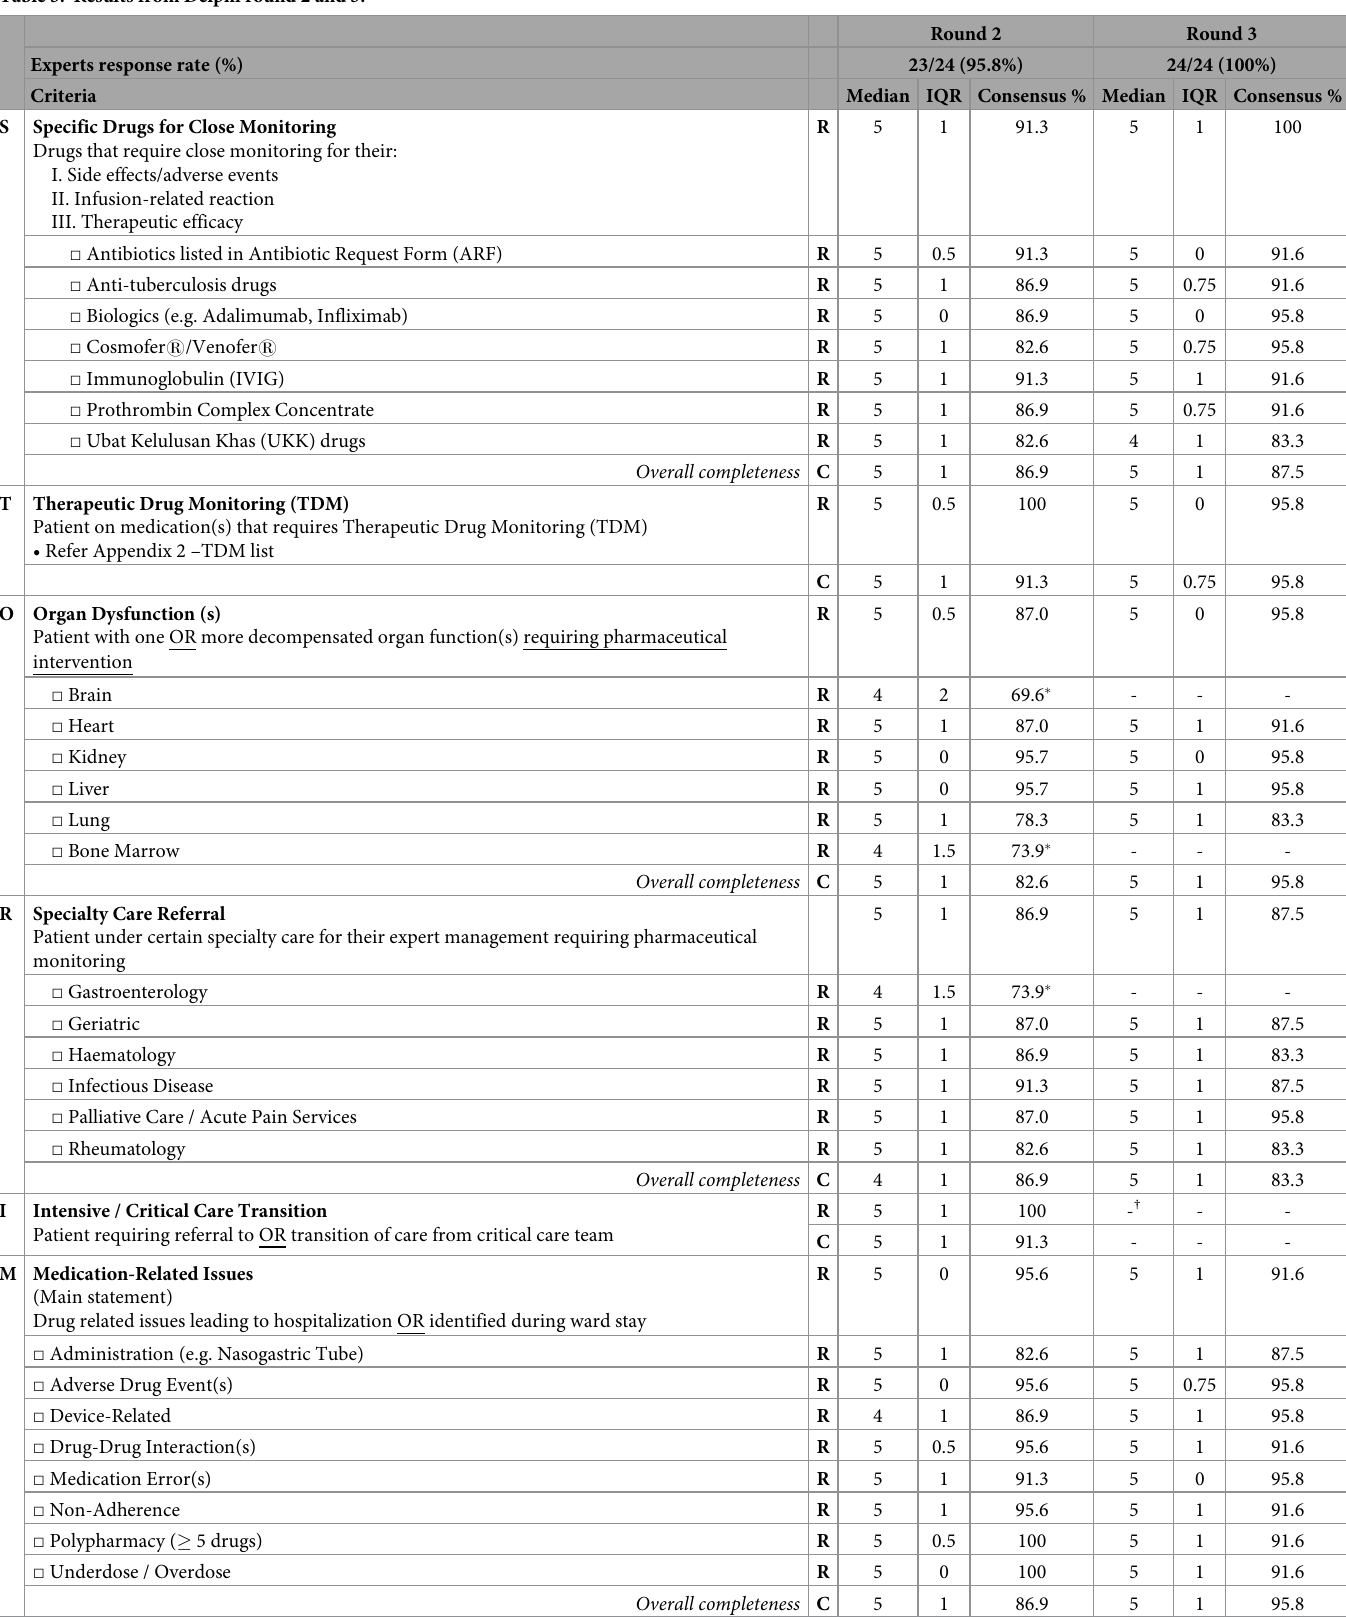
Table 3. Results from Delphi round 2 and 3.